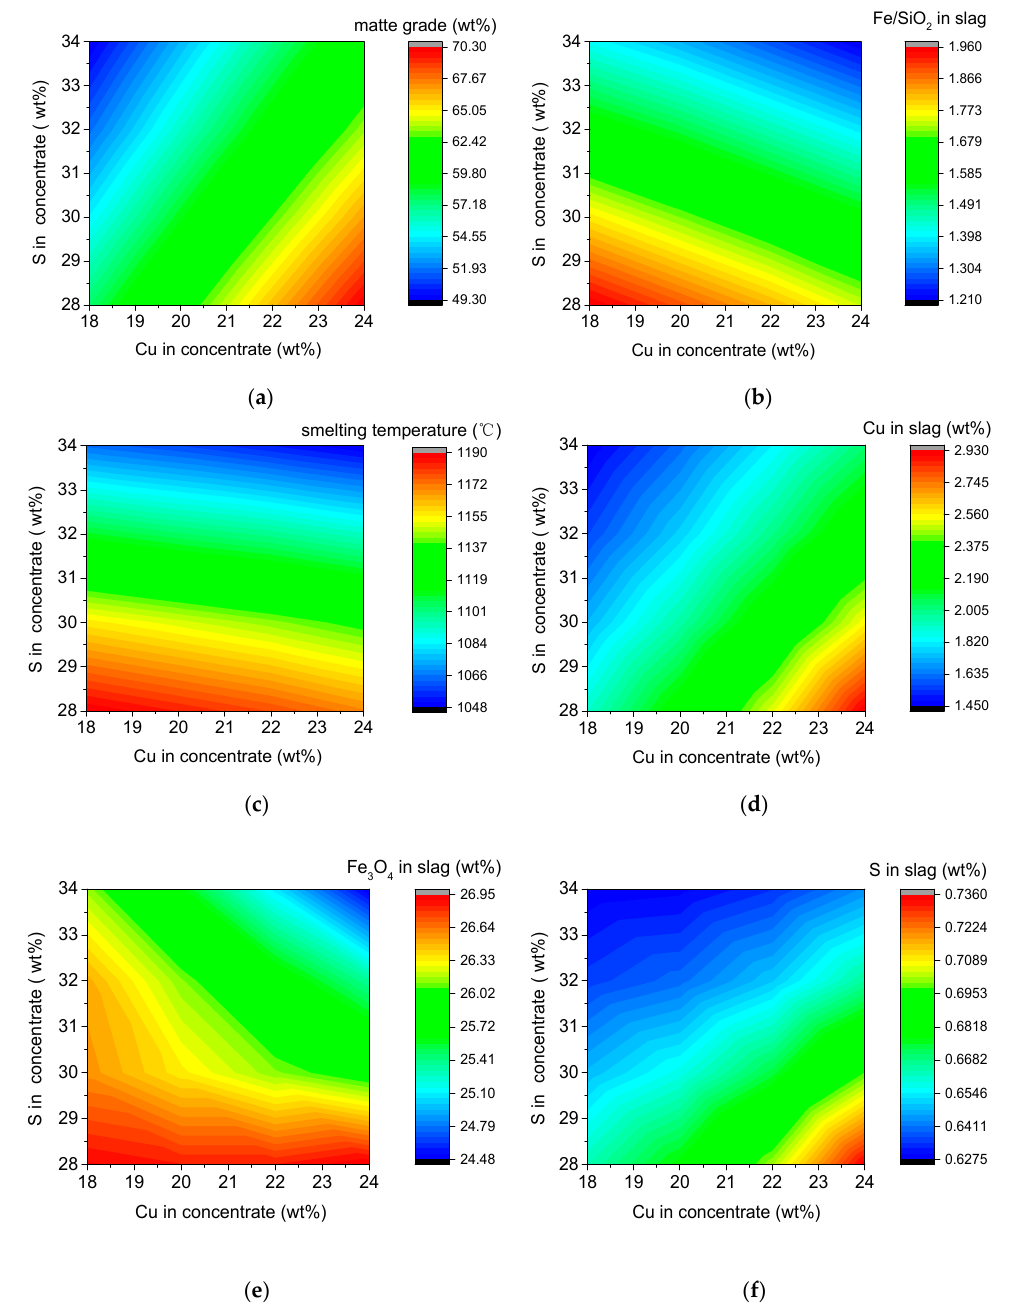
Figure 8. Interactive effects on other parameters of the SKS process: ( a ) matte grade; ( b ) slag type Fe/SiO 2 ; ( c ) smelting temperature; ( d ) copper loss to slag; ( e ) Fe 3 O 4 content in slag; ( f ) S content in slag.